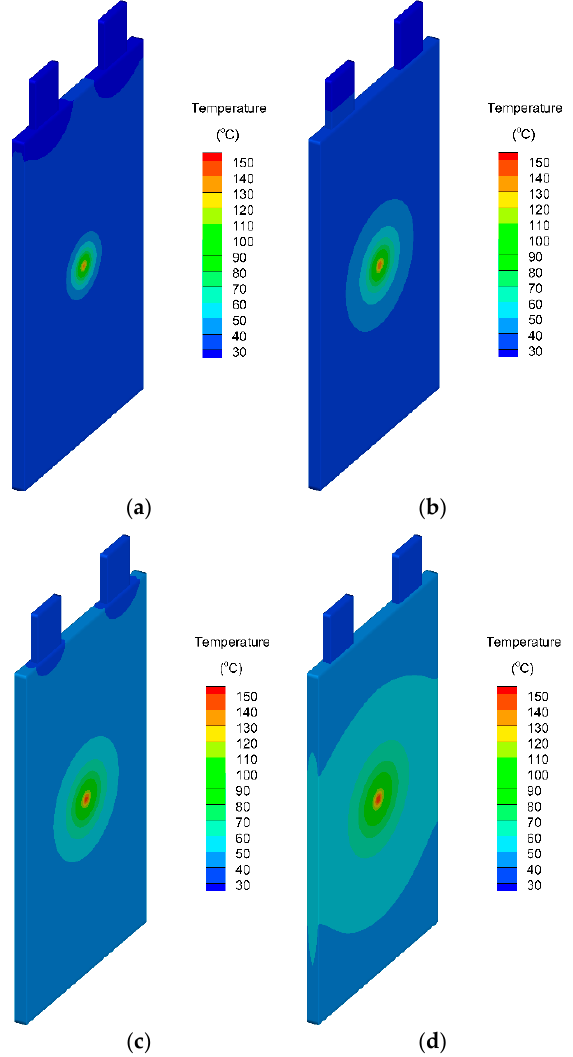
Figure 6. Temperature distributions of lithium-ion battery under internal shorting by 0.01 Ω after periods of ( a ) 15 s; ( b ) 30 s; ( c ) 45 s; ( d ) 60 s.